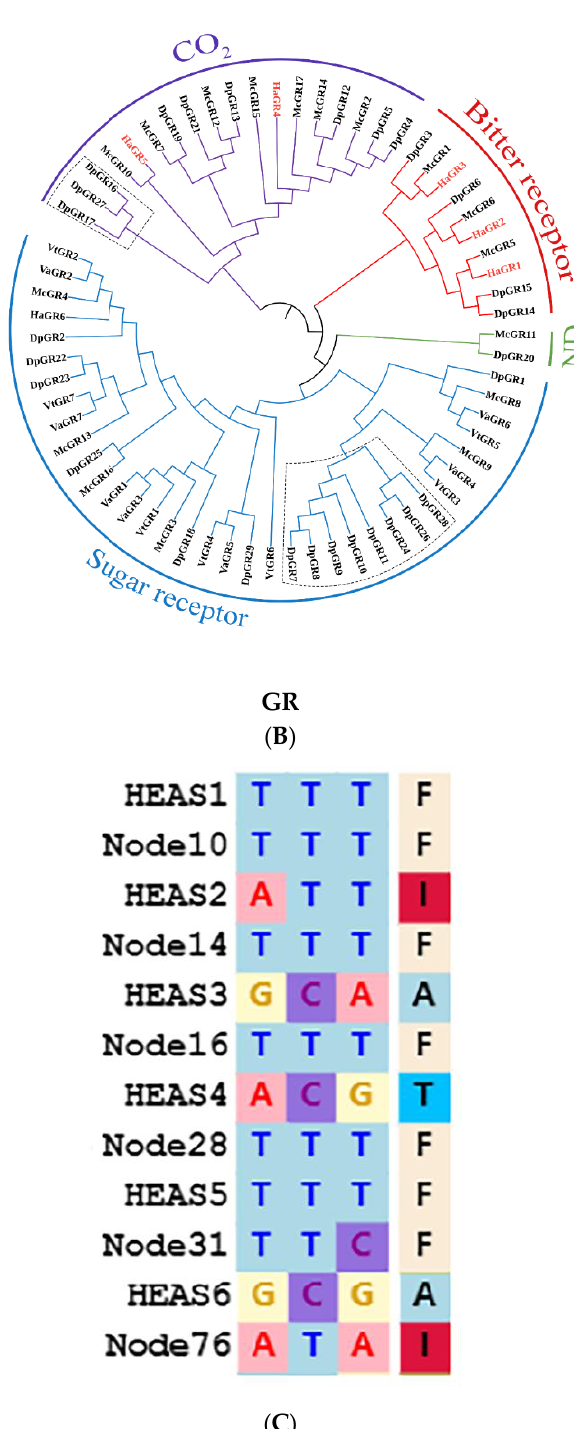
Figure 3. Chromosomal location and phylogenetic relationship of the detoxification and chemore- ception gene families in H. assimilis. ( A ) Chromosome distribution of cytochromes P450 (CYP , blue), olfactory receptor (OR, red), odorant binding protein (OBP, green), and gustatory receptor (GR, yel- low) genes. Chr2 – 27 represent chromosome numbers 02 – 27. ( B ) CYP, OR, OBP, and GR gene fami- lies in the genomes of H. assimilis (red), M. cinxia , V. tameamea , V. atalanta , and D. plexippus . ( C ) Non-synonymous substitution (996) in the CDS region of GR was significantly subject to positive se- lection.